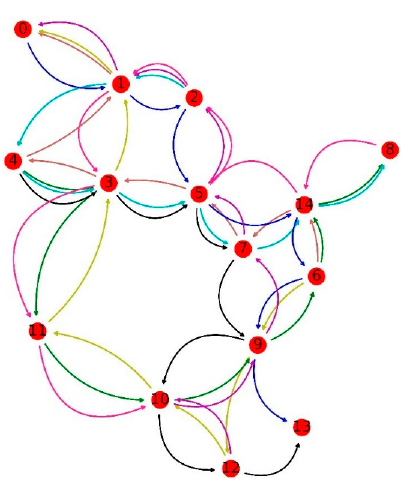
Figure 7. Best network with 8 routes.